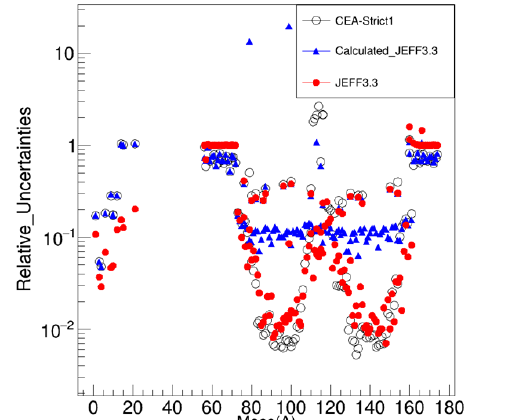
Fig. 21. Relative uncertainties of chain yields as a function of mass for the “Strict 1”